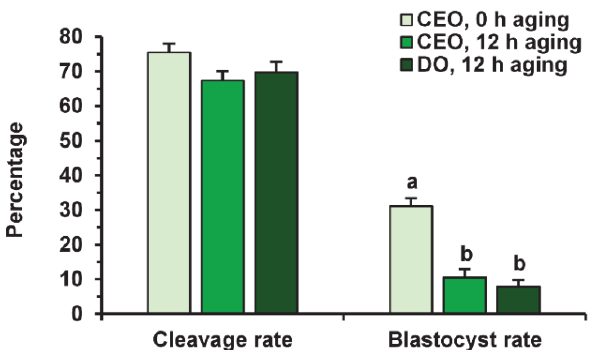
Figure 9. The developmental capacity of in vitro matured and aged bovine CEOs and DOs. Data represent means ± SEM of 6 replicates using 153–172 oocytes per treatment. Means marked with different letters differ significantly ( p < 0.001).